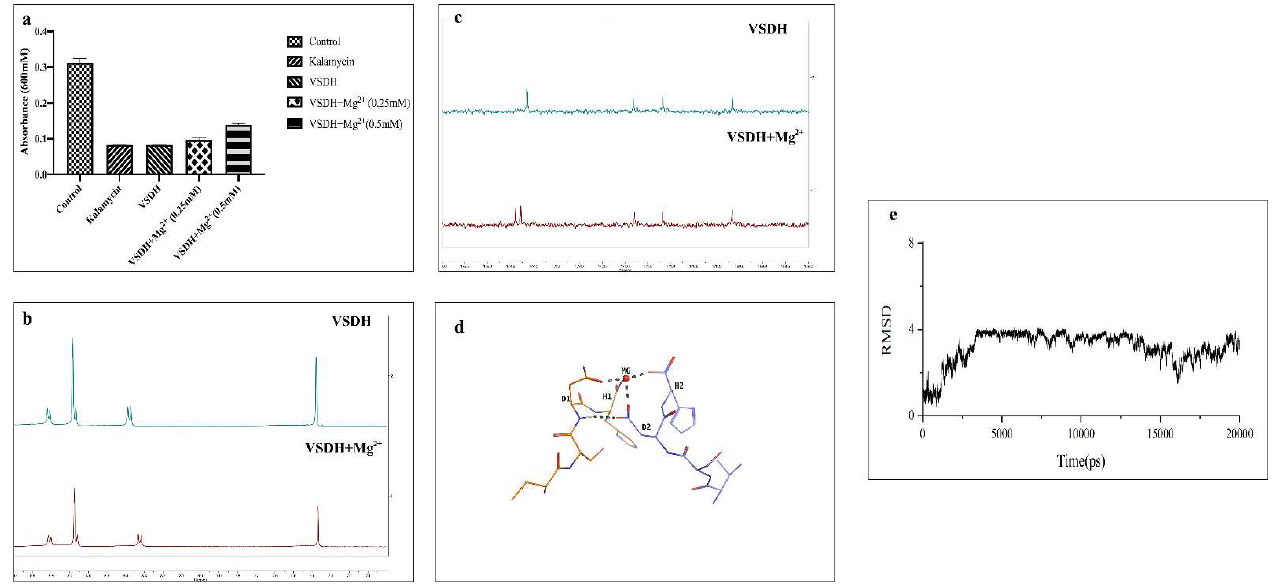
Figure 6 . Metal chelating ability of VSDH during the growth of B . cereus . ( a ) Cells were treated with Figure 6. Metal chelating ability of VSDH during the growth of B. cereus . ( a ) Cells were treated 0.5 mM VSDH for 18 h, and two concentrations of Mg 2+ were added for an additional 10 h . Optical density was determined at 600 nm . Data are presented as the mean ± SD, n = 3; ( b ) 1 H NMR spectra of the interaction between VSDH and Mg 2+ ; ( c ) 13 C NMR spectra of the interaction between VSDH and Mg 2+ ; ( d ) 3D structure of the VSDH - Mg 2+ complex; ( e ) Root mean square deviation (RMSD) plot for the VSDH - Mg 2+ complex during 20 ns of molecular dynamics simulation . 4 . Conclusions The two novel antibacterial peptides, VSDH and CCCPKAF, isolated from chicken plasma hydrolysates displayed unique characteristics with different antibacterial modes of action toward B . cereus. CCCPKAF exhibited a lower positive charge and disturbed the integrity of the cell membrane, which is a typical characteristic of AMPs . In contrast, VSDH is a short neutral peptide showing multiple mechanisms . It passed through the cell membrane and reacted with various intracellular targets, including proteins and DNA.